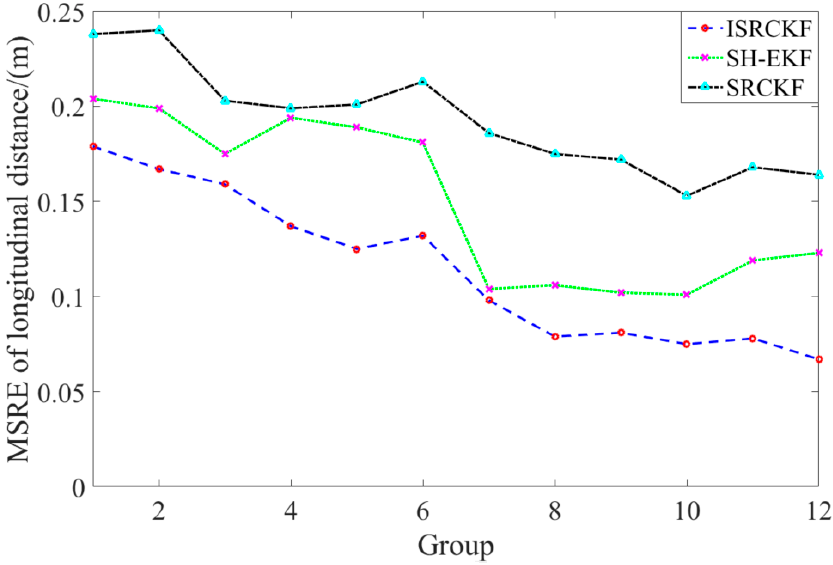
Figure 8. MSRE curves of longitudinal distance for various filters.